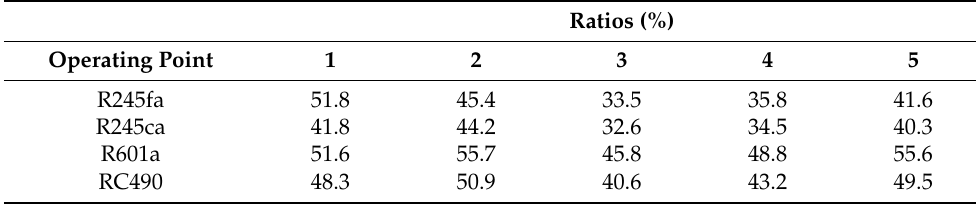
Table 13. Ratios of power loss to the expander power output.